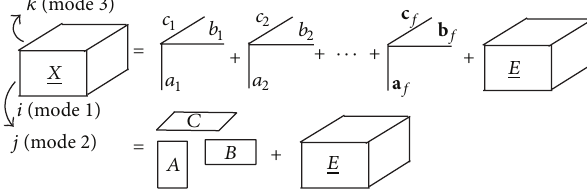
Figure 1: The graphical representation of parallel factor analysis (PARAFAC) model. Each factor has loading vectors a 𝑓 , b 𝑓 , and c 𝑓 , in each dimension of the three-way array 𝑋 .